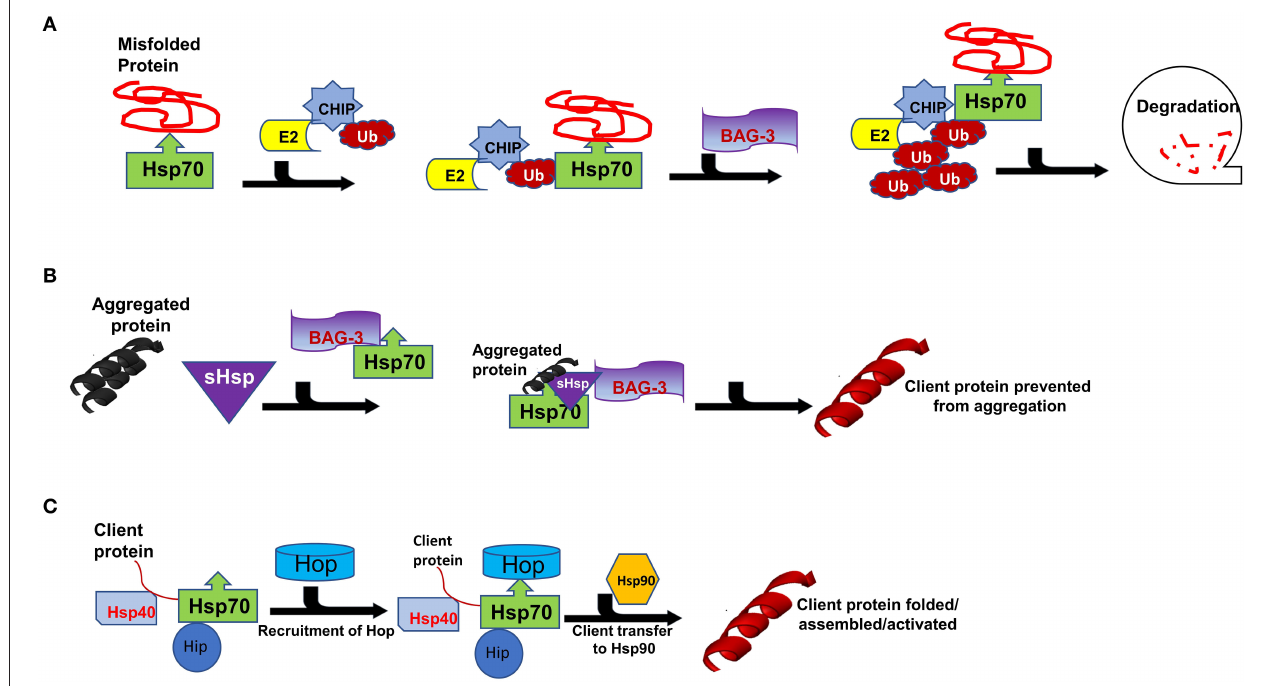
FIGURE 3 | Interaction of Carboxyl terminus of HSC70-interacting protein (CHIP) with binding partners for protein quality control. Hsp70 functions with co-chaperones CHIP, BAG3 and Hop in maintain cellular proteostasis. (A) The CHIP pathway involves the association of CHIP with Ub, E2, BAG3, Bcl-2-associated athanogene 3 and Hsp70 to facilitate degradation. (B) Formation of sHSPs-BAG3-HSP70 complex to prevent aggregation of proteins thus forming insoluble substrates in the cardiomyocytes. (C) Hsp70-Hsp90 Organising Protein (Hop) adaptor properties to link Heat shock protein 70 (Hsp70) with Heat shock protein 90 for client substrates